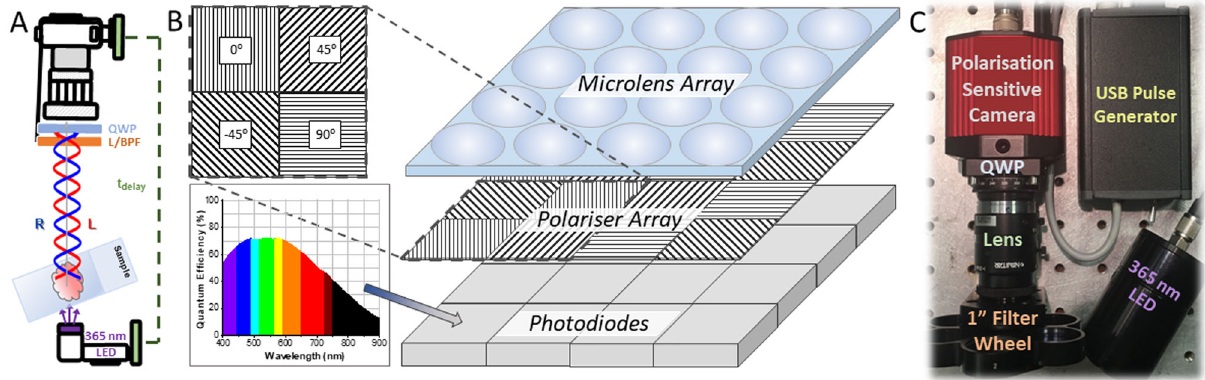
Fig. 3 | All solid-state camera for EDCC TR-CPLP. A Schematic diagram of the camera system and its time-resolved image capturing methodology. B Detailed schematics of the pixel layout and polarisation selector wire-grid alignment of the Kiralux® polarisation sensitive CMOS USB camera, displaying its wavelength- dependent quantum ef fi ciency (ThorLabs). C Picture of the apparatus with its synchronised 365nm LED (5.2V, 500mW) fl ash illuminator. The handheld USB